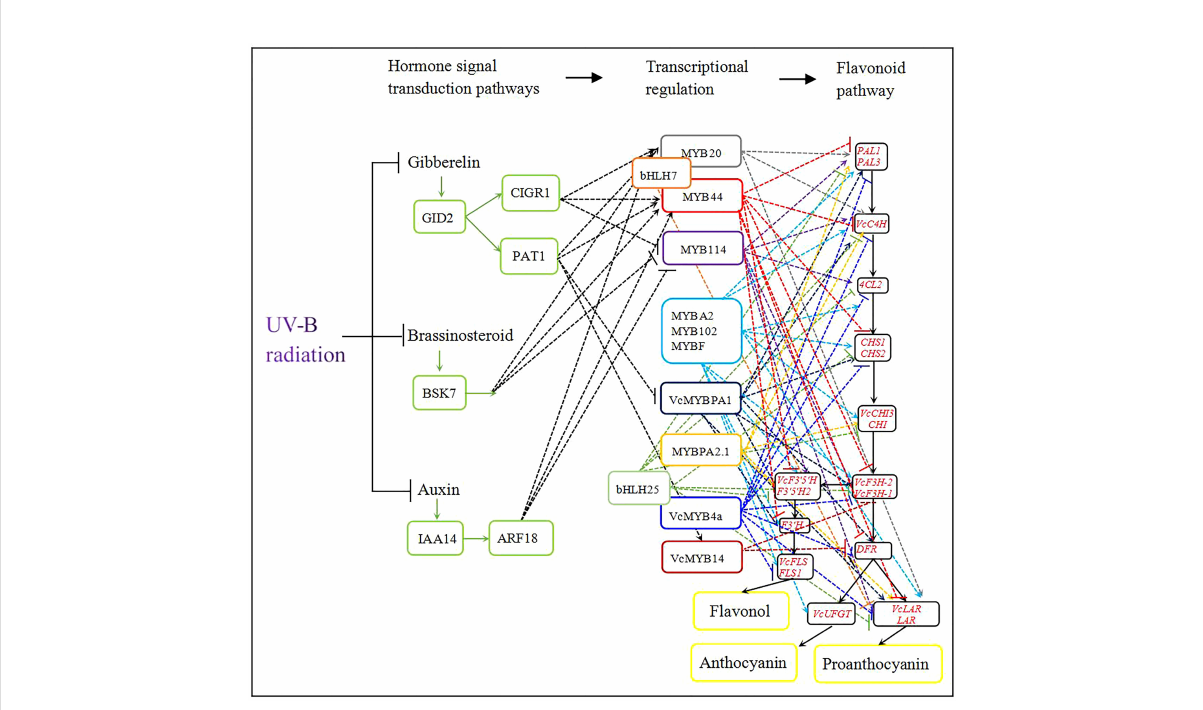
FIGURE 6 Model of the integration of UV-B-induced fl avonoid accumulation with plant hormone signal transduction pathways. Black solid lines represent the fl avonoid metabolic pathway and colored dashed lines represent regulatory pathways emanating from each transcription factor gene. In particular, green solid lines represent plant hormone signal transduction pathways and black dashed lines indicate MYB transcription factor genes that are regulated by a phytohormone. Arrows indicate activation; short lines indicate